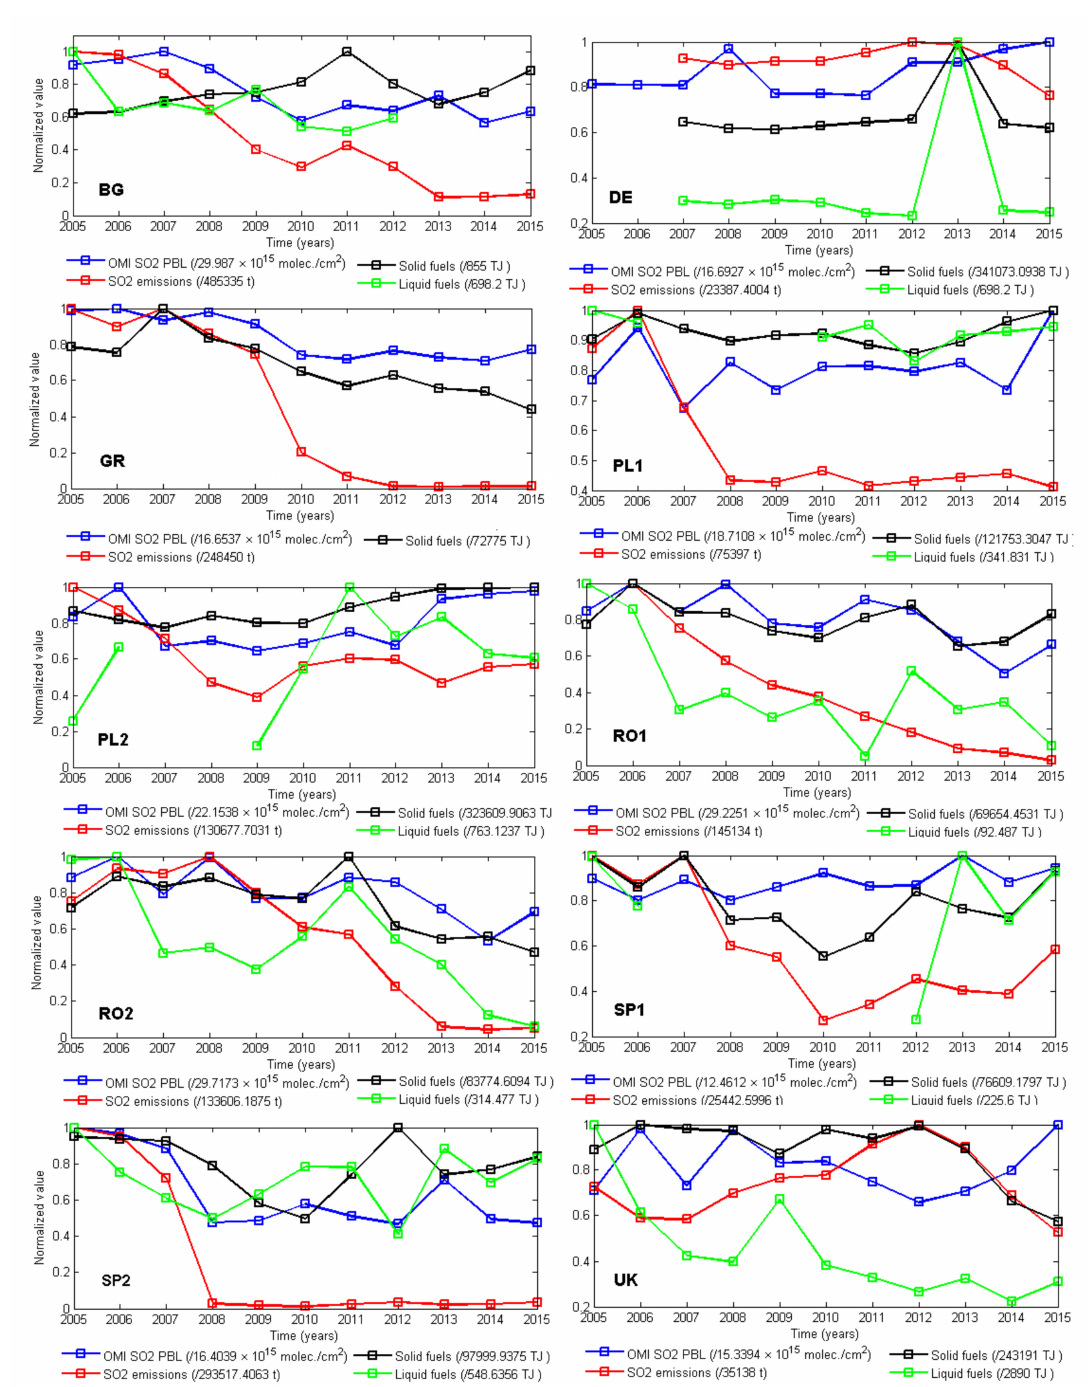
Figure 7. Time series of normalized SO 2 during 2005–2015 using data from satellite instruments (blue) and emissions (red), together with the reported solid fuel (black) and liquid fuel consumption